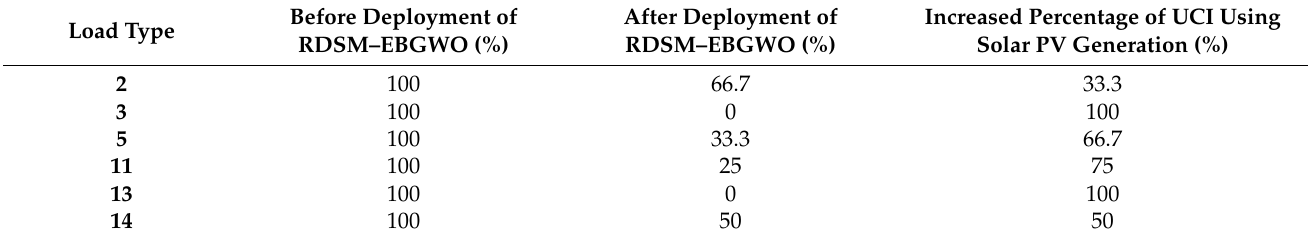
Table 6. User comfort index (UCI) before and after deployment of RDSM–EBGWO.